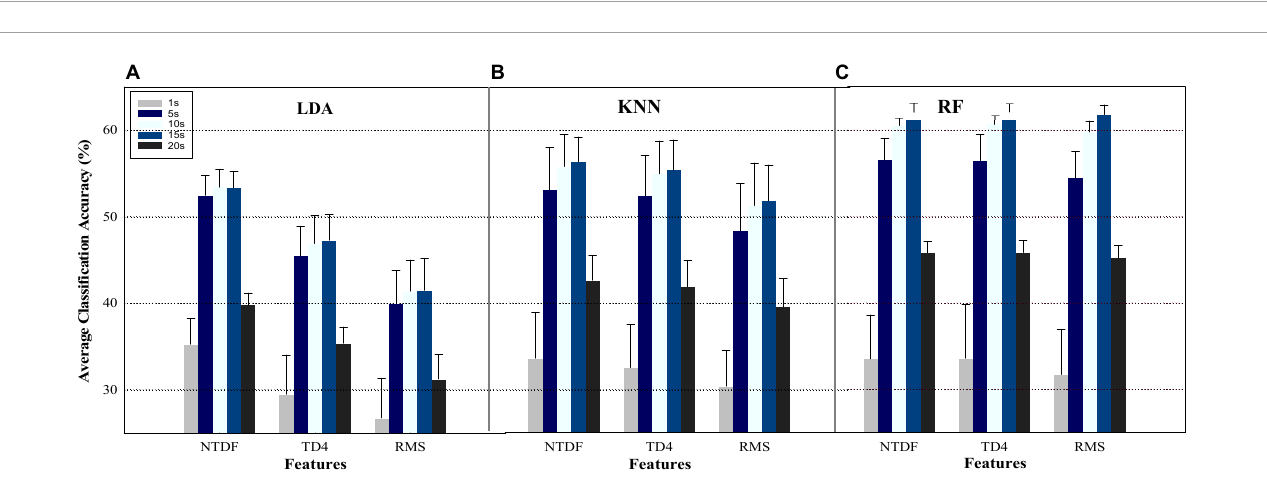
FIGURE4 Average classification performance across finger gestures and participants based on Between-SRD Approach using the NTDF, TD4, and RMS for (A) LDA, (B) KNN, and (C) RF when each of the SRD was used as a training data and tested with all SRD